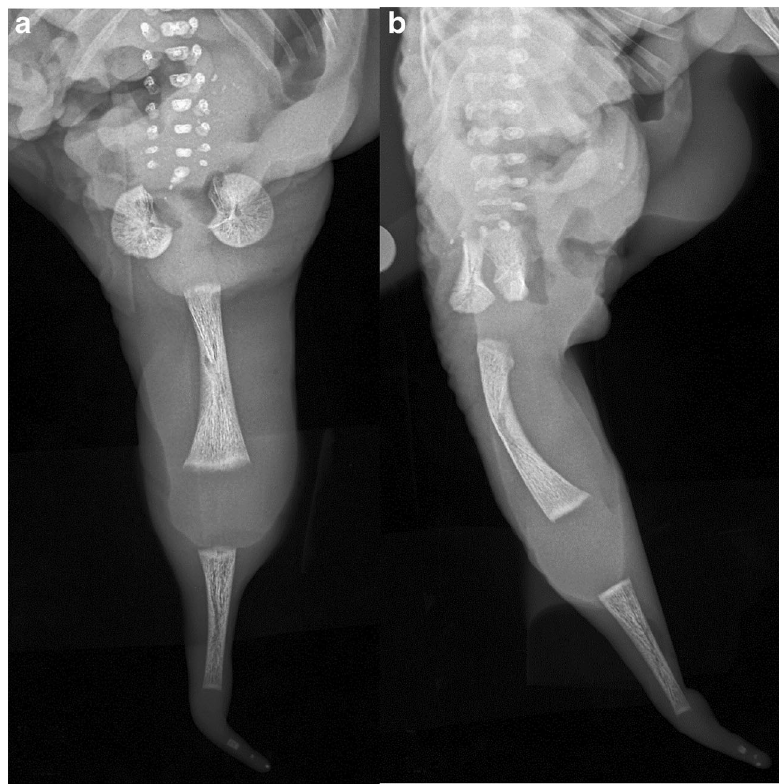
Fig. 6 a - b : Sirenomelia ( B mermaid sequence ^ ): Post- mortem AP ( a ) and lateral ( b ) ra- diographs of the lower body of a prematurely terminated foetus demonstrates absent sacrum and fused bilateral lower extremities. This anomaly is incompatible with life